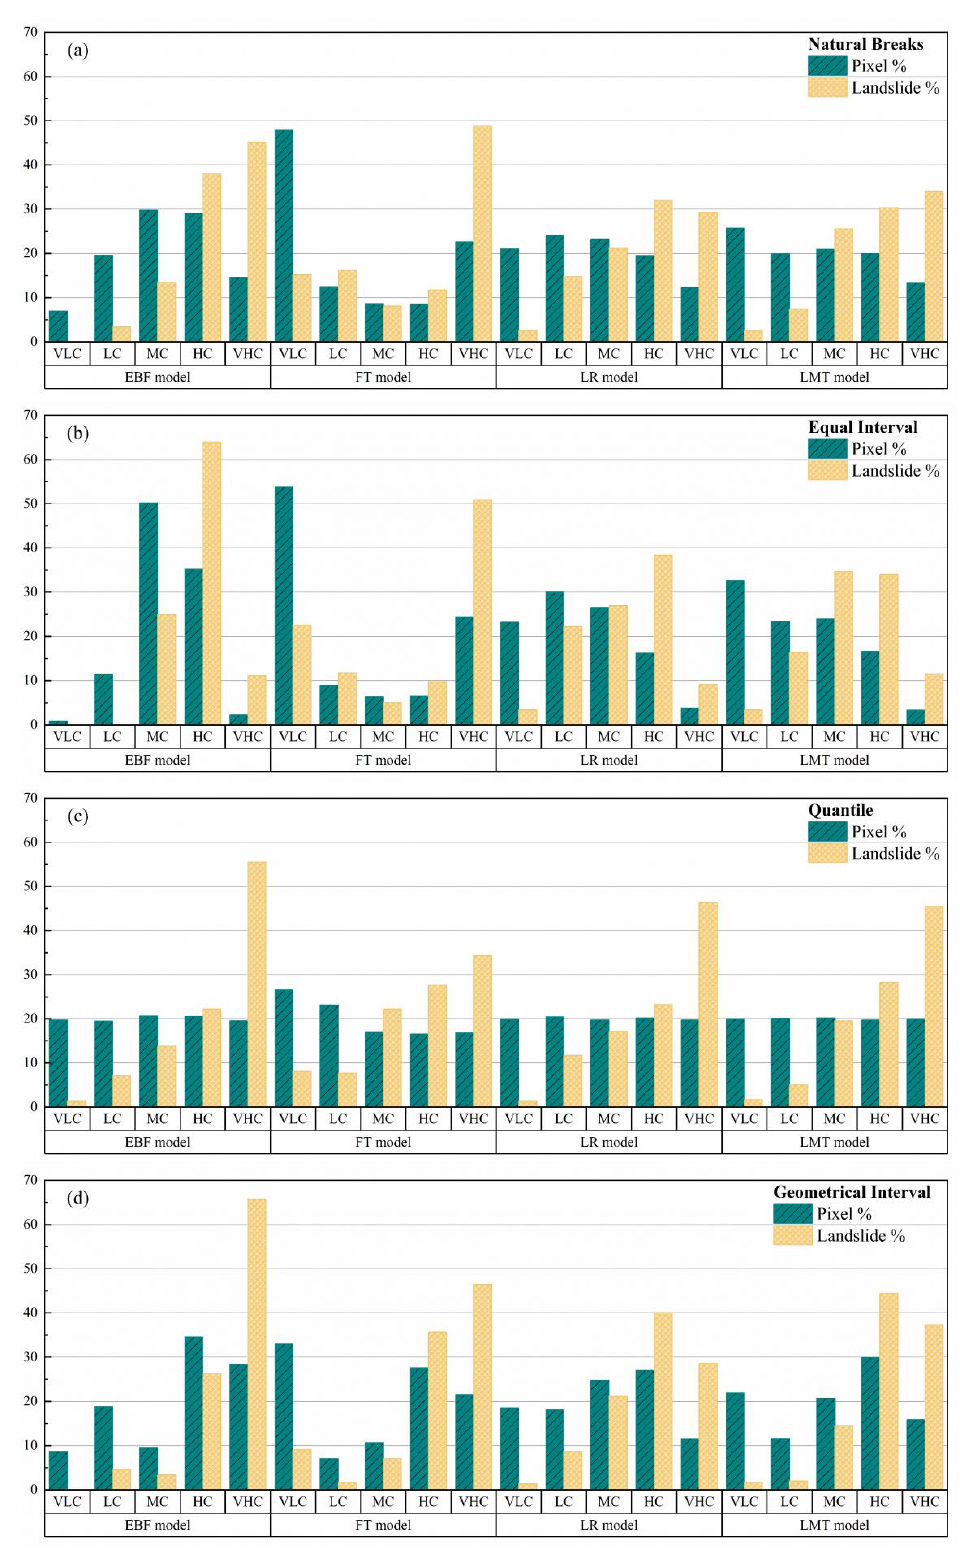
Figure 13. Selection of the best classification method for landslide susceptibility maps: ( a ) natural breaks, ( b ) equal interval, ( c ) quantile, and ( d ) geometrical interval.